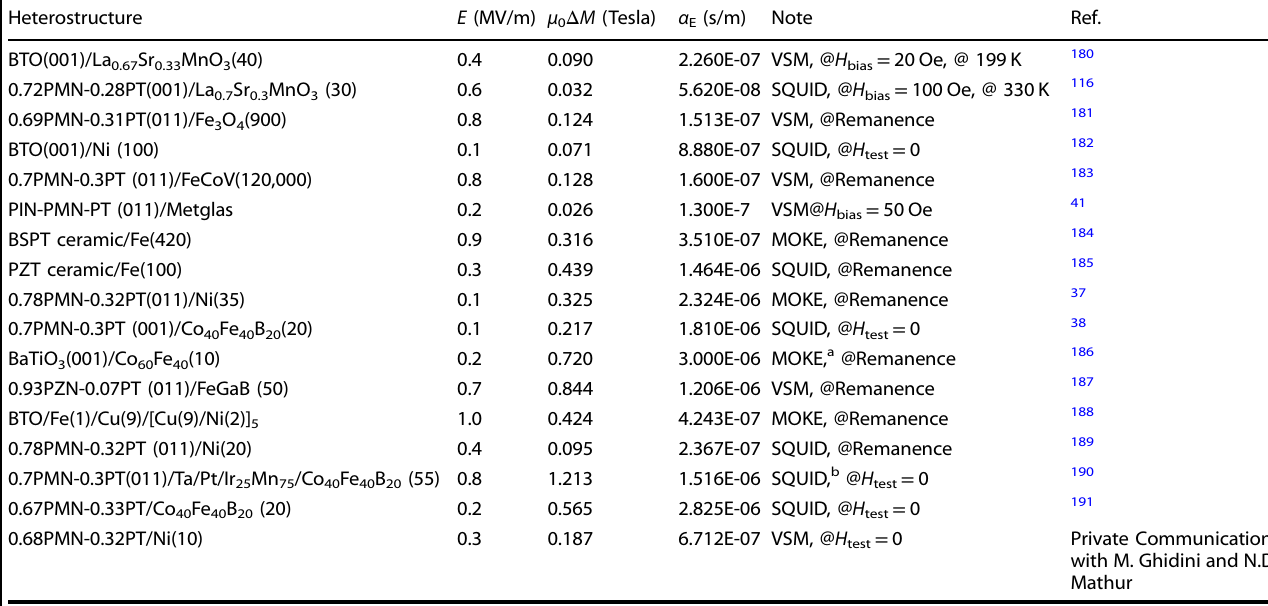
Table 3c. Converse magnetoelectric coupling mediated by the transfer of E -induced strain across the interface Heterostructure Note